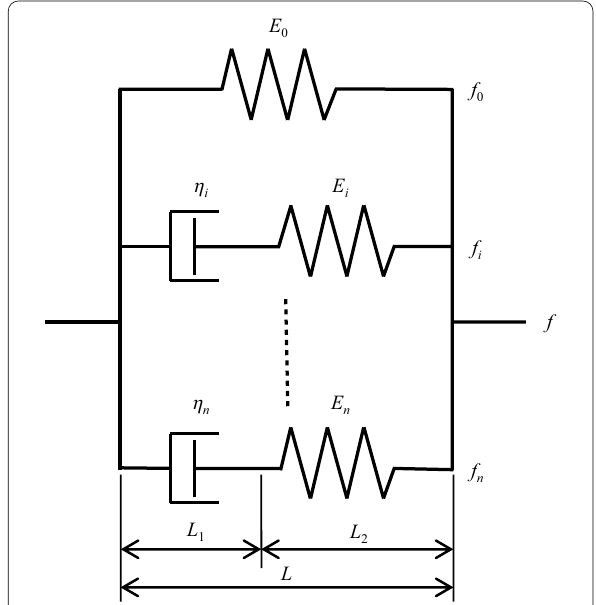
Fig. 8 Generalized Maxwell model used in present